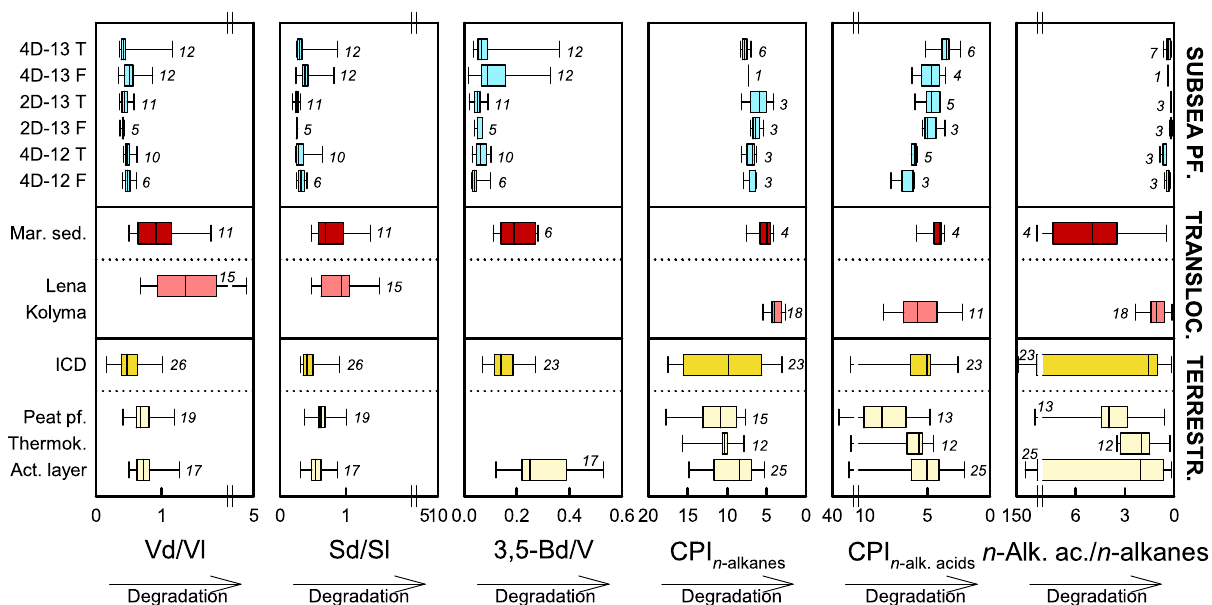
Fig. 6 | Comparison of biomarker degradation proxies in subsea permafrost with other deposits in northeastern Siberia. Subsea permafrost (pf.) data representthethawfrontsofcores4D-13,2D-13,and4D-12fromtheBuor-KhayaBay. Data from previous studies include terrestrial deposits such as Ice Complex deposits (ICD) 14,36,44,48 , Holocene peat permafrost 14,45 , Holocene thermokarst (thermok.) 36 , and active layer material (act. layer) 44,45,48 , as well as translocated material such as Buor-Khaya Bay surface sediments (mar. sed.) 14,42,46 , Lena 14 and